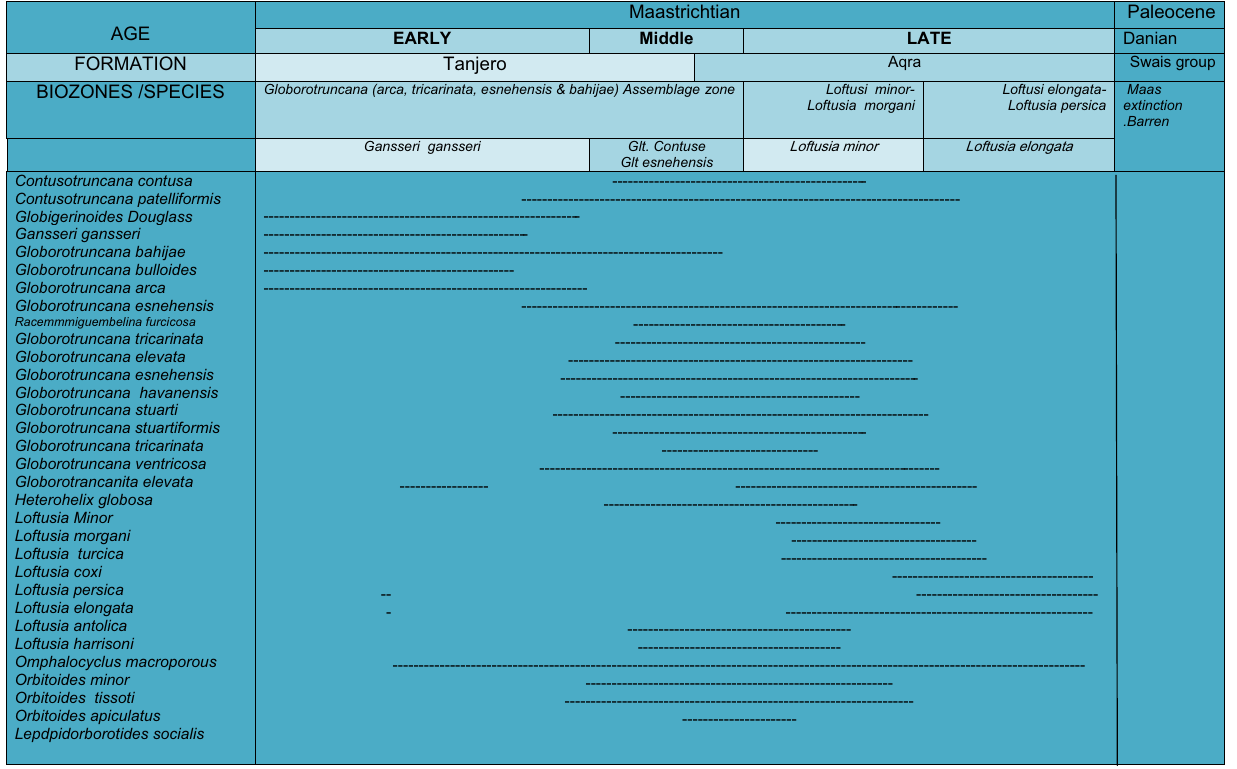
Table 3 General distribution chart of planktonic and large foraminifera within Tanjero and Aqra formations (Early to Late Maastrichtian)